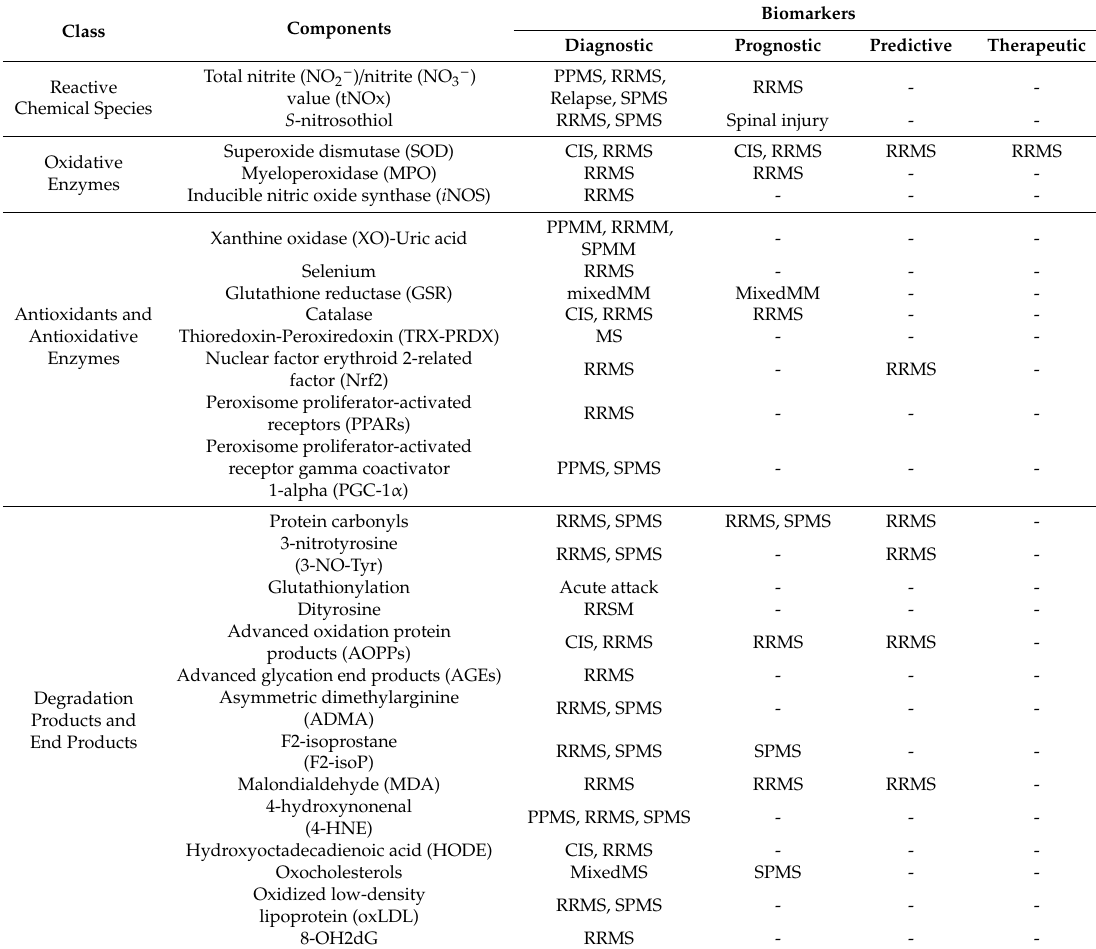
Table 4. Possible redox biomarkers in multiple sclerosis. Reactive chemical species, oxidative enzymes, antioxidants, antioxidative enzymes, degradation products, and end products are potential biomarkers for multiple sclerosis (MS). Diagnostic biomarkers allow early detection and secondary prevention; prognostic biomarkers suggest the likely clinical course; predictive biomarkers predict the response of MS patients to a specific therapy; and therapeutic biomarkers indicate a target for therapy. CIS: clinically isolated syndrome, PPMS: primary progressive MS; RRMS: relapsing-remitting MS, SPMS: secondary progressive MS, mixedMM: mixed population of